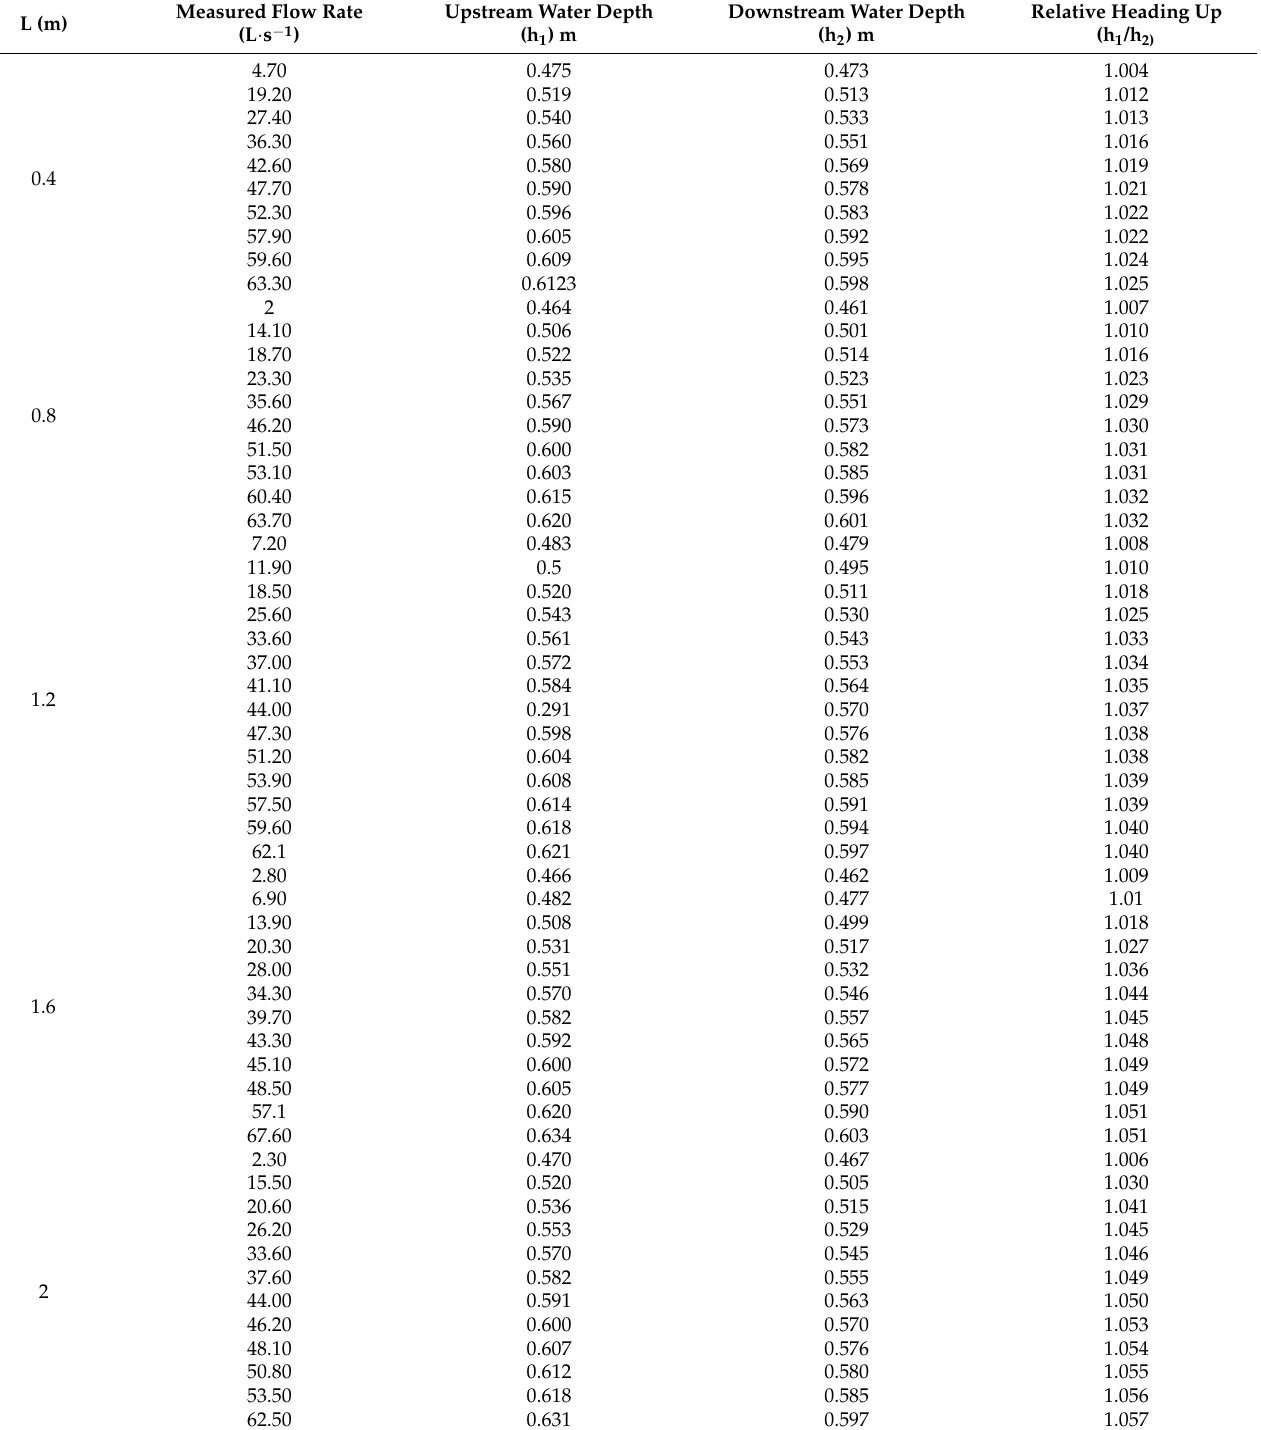
Table 3. The measured flow rate and water depths upstream and downstream of the biofilter and the resulting relative heading up (h 1 /h 2 ) for different SB